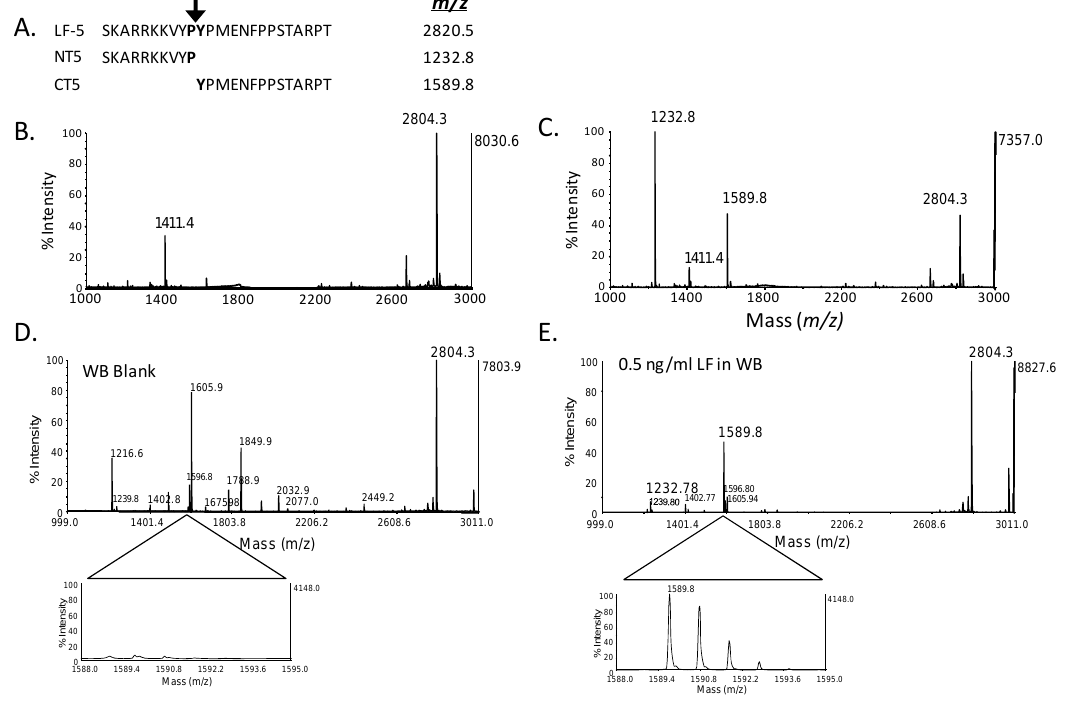
Figure 3. Specificity of MALDI-TOF MS detection of LF hydrolytic activity. Amino acid sequence and expected mass/charge ( m/z ) of lethal factor (LF) endoproteolytic MAPKK- like substrate (LF-5) and LF-specific hydrolysis products; amino-terminal product (NT5) and carboxy-terminal product (CT5) (A). MALDI-TOF MS of 2 nmoles LF-5 substrate and reaction buffer without LF (B) and with 1 ng LF (C). Both reactions, with and without LF, were incubated for 2 hours at 37 °C, and analyzed by MALDI-TOF MS scanning from 1,000–3,000 m/z . MALDI-TOF MS of 200 µL whole blood without LF (WB blank) (D) and spiked with 0.5 ng/mL LF (E) and purified with LF mAbs covalently bound to tosyl- activated magnetic beads, incubated overnight in a reaction buffer containing 2 nmoles substrate. Narrowing the m/z range on the CT5 ( m/z 1,589.8) product shows the specificity for LF cleavage without LF (D) and with LF (E). Signal intensity for the CT5 focused mass window for WB blank was normalized to the focused spectrum for the 0.5 ng/mL LF spiked in